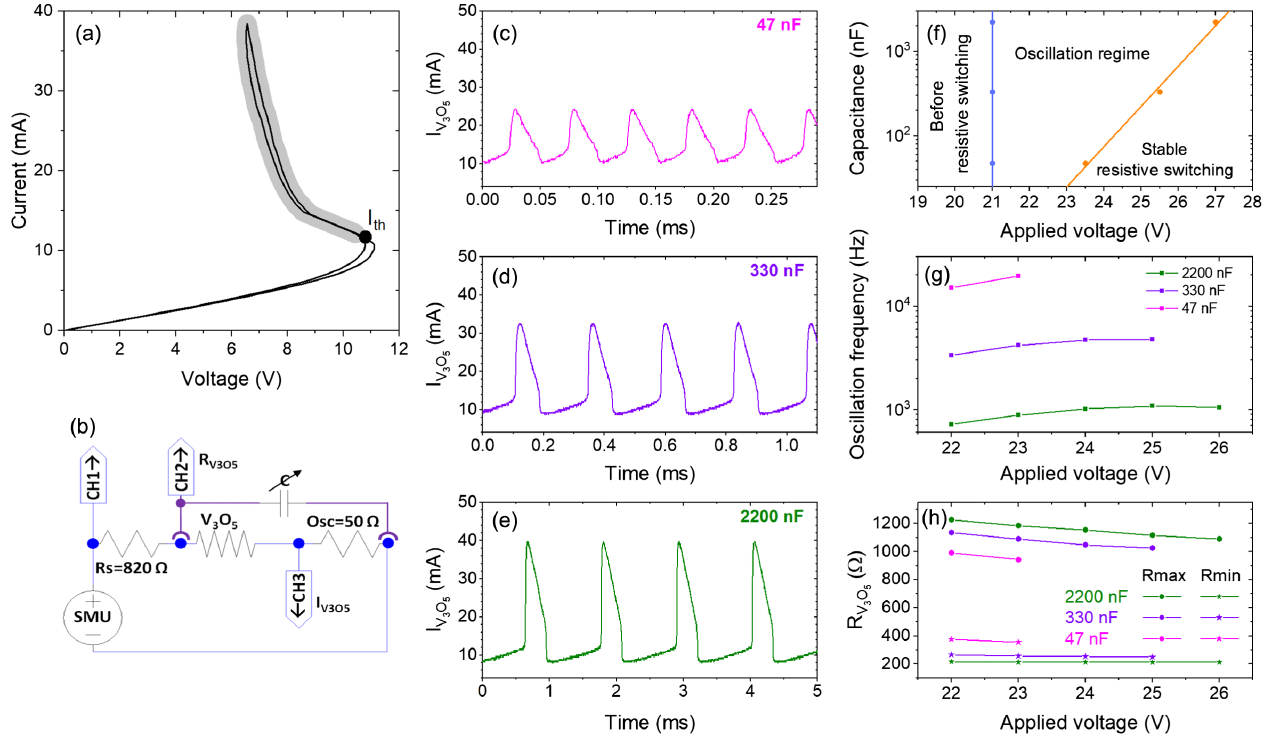
FIG. 2. Resistive switching and self-oscillation in V 3 O 5 . (a) RT current-voltage characteristic. Above approximately 12 mA threshold current, the V 3 O 5 device switches into a low-resistance state as indicated by the appearance of an S-type NDR ( dV=dI < 0 ) regime (gray shaded area in the I - V plot). (b) Pearson-Anson circuit used in the self-oscillation measurements. (c) – (e) Time dependence of the current through the V 3 O 5 device for different capacitances: 47 nF in (a), 330 nF in (b), and 2200 nF in (c). (f) Summary of the three different regimes as a function of the capacitance and the applied voltage. For voltages below 21 V, the device is always insulating. Above 21 V, the device enters an oscillation regime that ends at higher voltages where the resistive switching state is stable. (g) Oscillation frequency as a function of the applied voltage for different capacitance. The frequency decreases as the capacitance increases but increases with the voltage. (h) Minimum and maximum resistances of the V 3 O 5 device during the oscillation regime as a function of the voltage and for different capacitances. Both the amplitude of the resistance change and the extrema resistance values depend on the capacitance. The maximum resistance decreases slowly with the applied voltage independently of the capacitance, and the minimum resistance is nearly independent of the